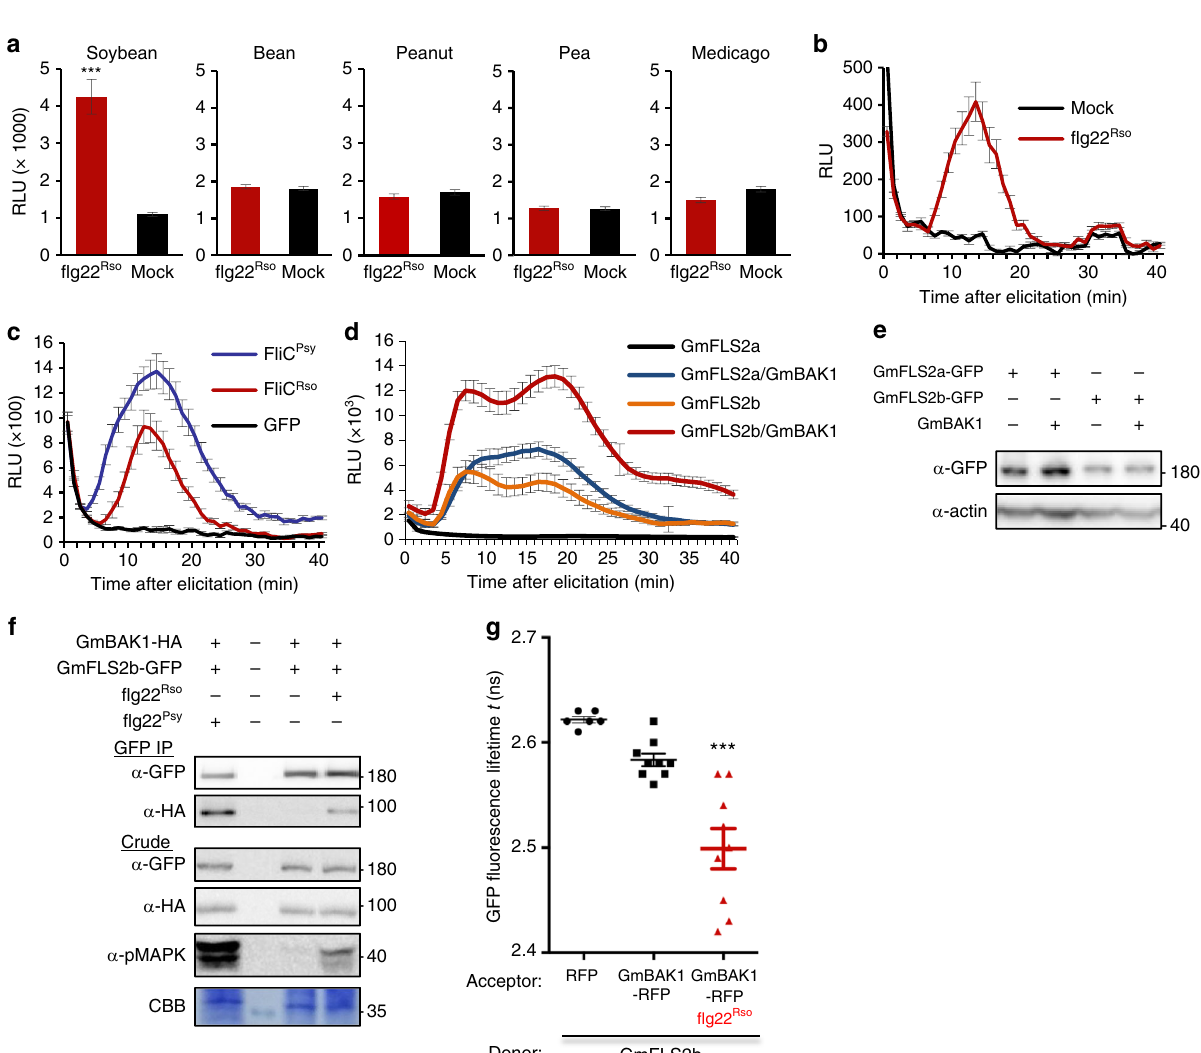
Fig. 2 The soybean FLS2/BAK1 complex perceives R. solanacearum fl g22. a ROS burst triggered by fl g22 Rso (100 nM) or a mock (water) treatment in leaf discs from the indicated plant species, measured in a luminol-based assay, and represented as accumulated relative luminescence units (RLU) (mean ± SEM, n = 8). Asterisks indicate signi fi cant differences compared to the mock control as established by a Student ’ s t test ( p < 0.001). The measurement was performed from 5 to 40 min after treatment to avoid the effect of the background signal during the fi rst 5 min. b Dynamics of ROS burst triggered by fl g22 Rso (100 nM) or a mock (water) treatment in leaf discs from soybean. The measurement was performed from 1 to 60 min after treatment. c Dynamics of ROS burst triggered by 100 nM full-length recombinant fl agellin (FliC) from R. solanacearum GMI1000 (FliC Rso ) or P. syringae DC3000 (FliC Psy ) in soybean leaf discs, measured in a luminol-based assay, and represented as relative luminescence units (RLU) (mean ± SEM, n = 8). Recombinant GFP protein was used as control. The measurement was performed from 1 to 40 min after treatment. d Dynamics of ROS burst triggered by fl g22 Rso (100 nM) in N. benthamiana leaf tissues expressing the indicated GmFLS2 versions (with a C-terminal GFP tag), alone or together with untagged GmBAK1, from a 35S promoter. ROS was measured in a luminol-based assay, and represented as accumulated relative luminescence units (RLU) (mean ± SEM, n = 16). The measurement was performed from 1 to 40 min after treatment. e Accumulation of GmFLS2a/b-GFP expressed in ( d ). Immunoblots were analysed using anti-GFP and anti-actin (to verify equal loading). f Co-immunoprecipitation assays to determine interactions between GmFLS2-GFP and GmBAK1-HA transiently expressed in N. benthamiana , upon treatment with the indicated peptides (1 μ M) for 10 min. Immunoblots were analysed with anti-GFP, anti-HA, and anti-pMAPK, and stained with Coomassie Brilliant Blue (CBB) to verify equal loading. In immunoblots, protein marker sizes (KDa) are provided for reference. g Interaction between GmFLS2-GFP and GmBAK1-RFP determined by FRET-FLIM upon transient co-expression in N. benthamiana leaves. Free RFP was used as a negative control. Lines represent average values ( n = 8) and error bars represent standard error. Asterisks indicate signi fi cant differences compared to the RFP control as established by a Student ’ s t test ( p < 0.001). All the experiments were repeated at least three times with similar